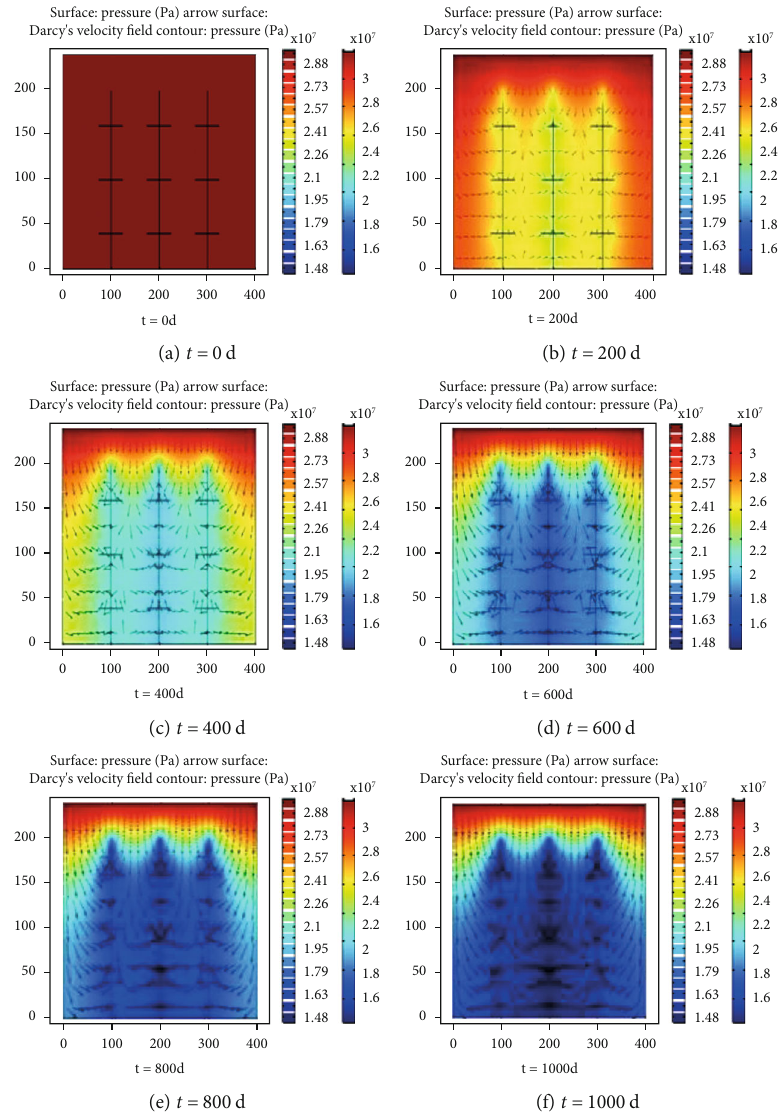
Figure 4: Distribution nephograms of reservoir pressure and velocity fi eld over time under nonconstant gas